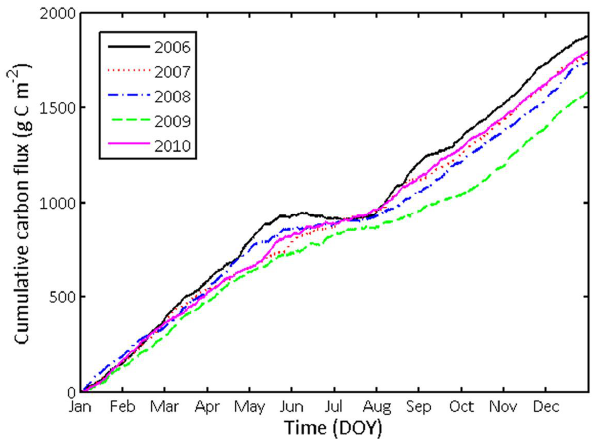
Fig. 8. Annual cumulative sums of F c (in gCm − 2 ) for different years. Data was gap filled using ANN traffic